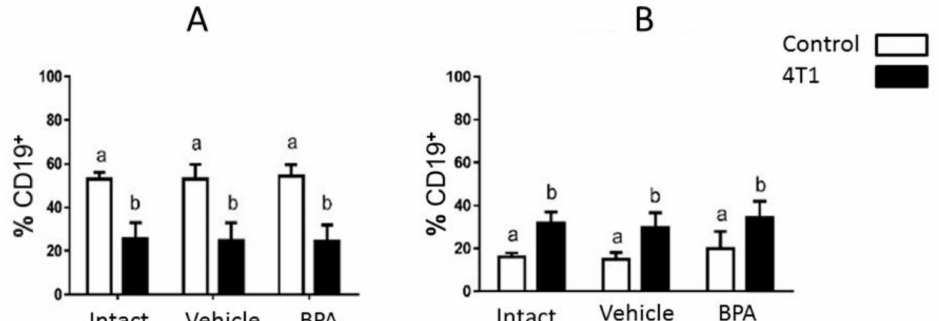
Figure 2. ( A ): B lymphocyte population in spleen. B lymphocytes are diminished in tumor bearing animals. ( B ): Population of B lymphocytes in draining peripheral lymph nodes. An increase in